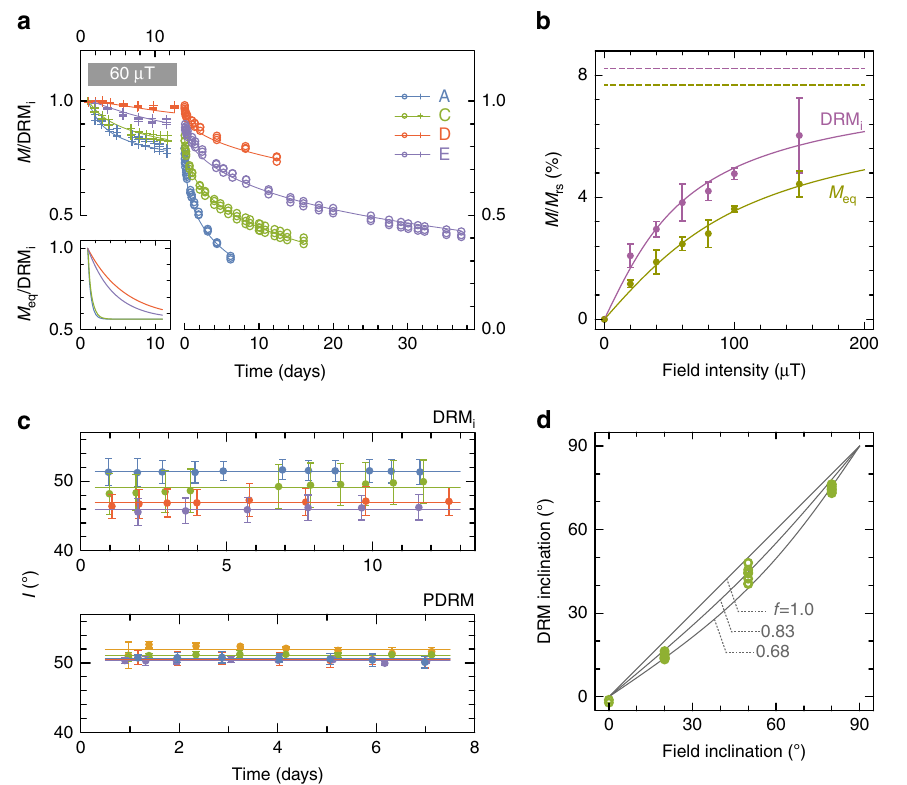
Figure 5 | DRM acquisition experiments. ( a ) DRM acquisition in a 60- m T field with 50 (cid:2) inclination for the sediment groups A, C, D and E, as well as subsequent decay in a null field. Zero-field decay curves have been modelled using equations (2 and 3) (solid lines). The median rotational diffusion coefficients deduced from these models were used to fit the DRM acquisition curves, taking into consideration that the initial DRM (that is, DRM i ) is progressively replaced by a PDRM acquired in the applied field. Because of initial sediment compaction and stabilization, it was assumed that the equilibrium PDRM intensities ( M eq ) decrease exponentially from an initial state, characterized by DRM ¼ PDRM at the beginning of deposition (that is, M eq /DRM i ¼ 1, see inset), to a final value of M eq /DRM i matching the measurements shown in b . The exponential decrease of M eq needed to model the observed DRM changes in time (inset) is faster for sediments containing more bacteria (that is, groups A and C). ( b ) Dependence of DRM i and M eq on field intensity. M eq was calculated from the PDRM acquisition curves as shown in Fig. 3. Solid lines are least-squares fits with M ¼ M 0 S ( B / B 0 ),